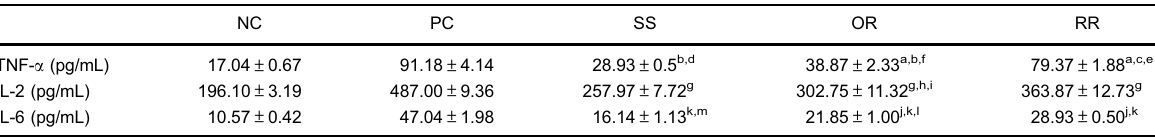
Table 1. The effects of ro fl umilast on serum levels of TNF- a , IL-2, and IL-6 in rats with trinitrobenzenesulfonic acid (TNBS)-induced colitis (n=8).